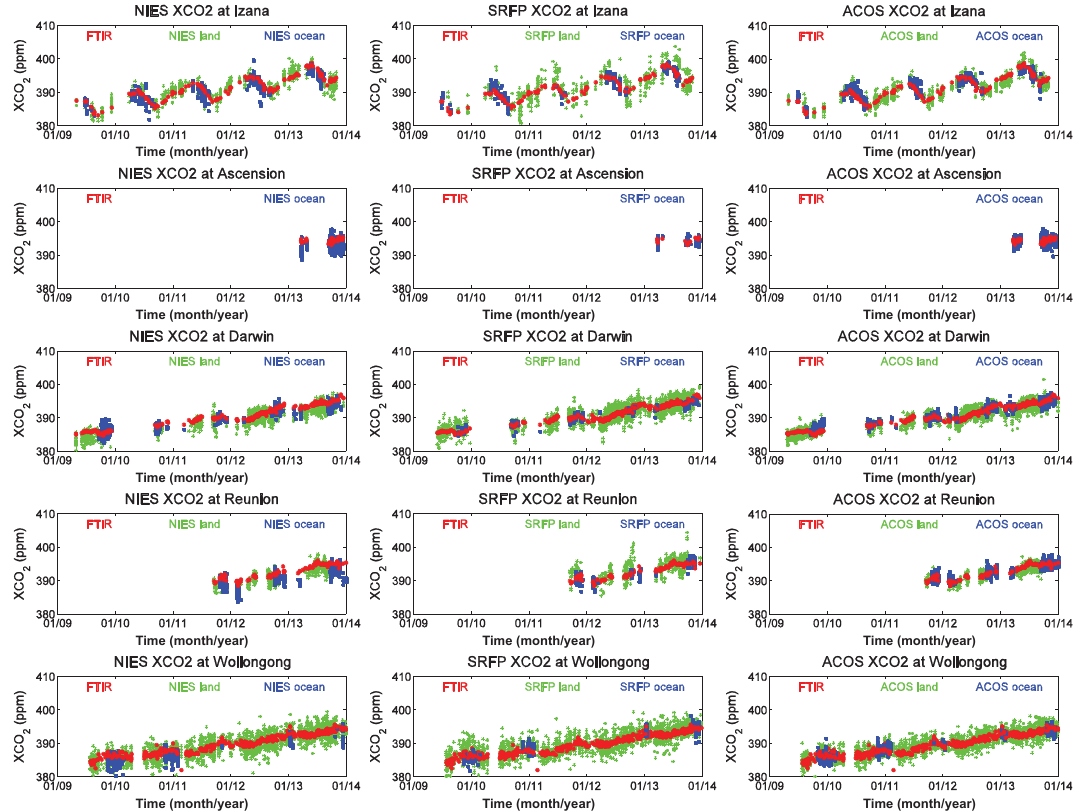
Figure 4. Time series plots of TCCON and GOSAT XCO 2 measurements based on the individual data pairs. Left, middle and right panels correspond to NIES, SRFP and ACOS algorithms, respectively. Red points represent the FTIR measurements; blue and green ones represent the GOSAT glint data over ocean and the normal nadir data above land,